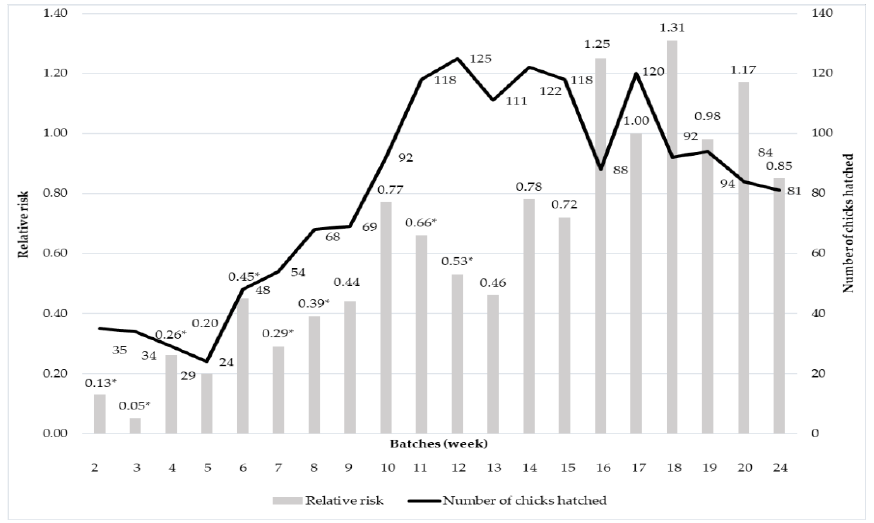
Figure 2. The effect of hatching order in the year on the relative risk of total loss. *Statistically significant difference from the reference group ( p ≤ 0 .05).